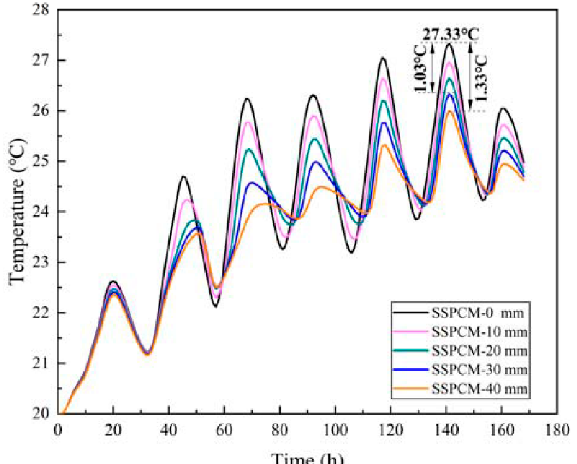
Figure 10. The internal surface temperature of SSPCM granary wall with different SSPCM layer thicknesses.